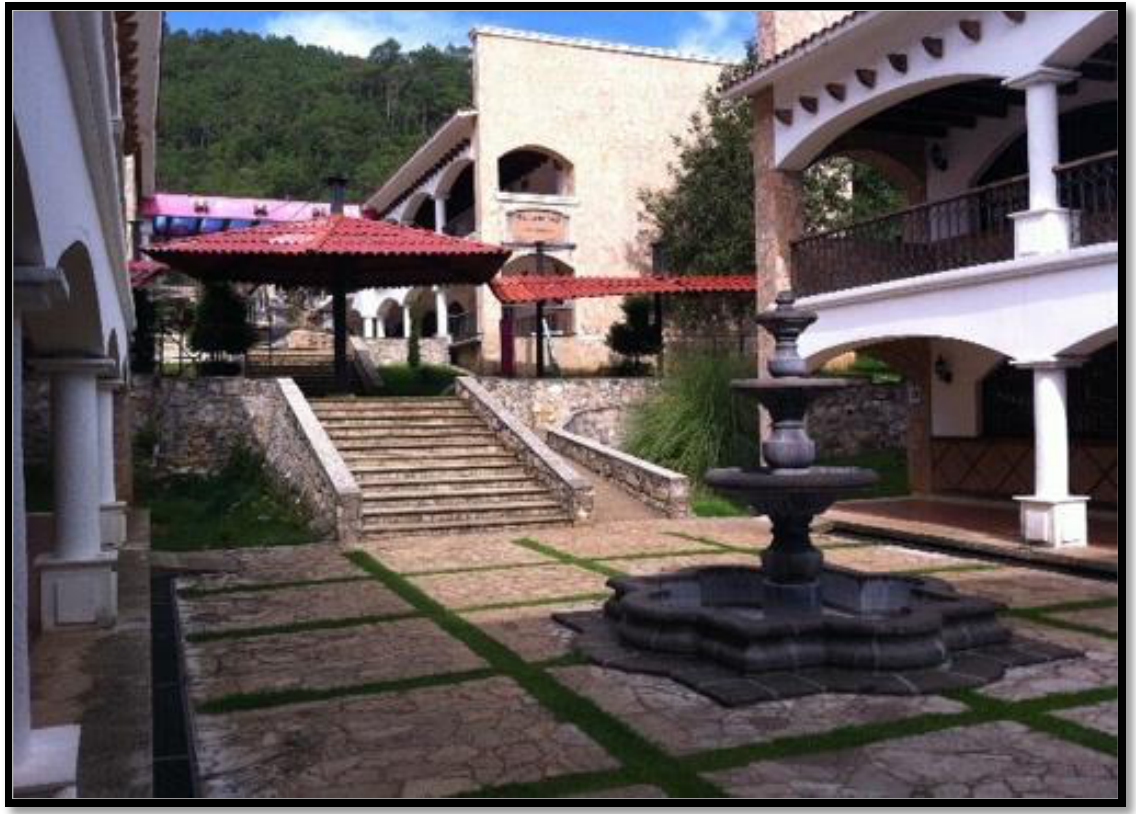
Figure 2, Architecture of the Intercultural University of Chiapas Source Architect of the